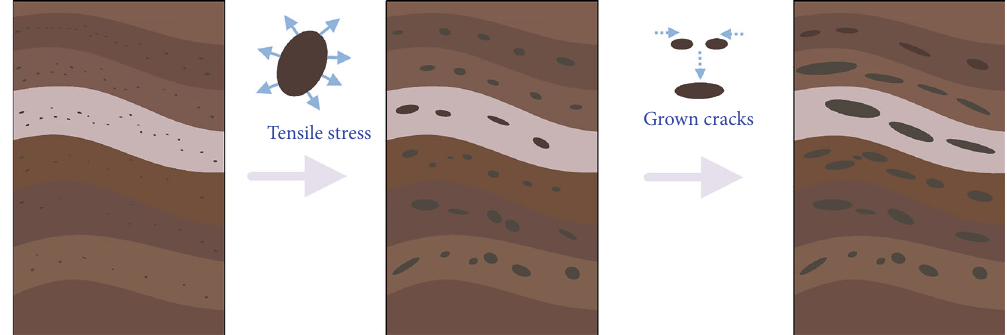
Figure 1: Schematic diagram of periodic freeze-thaw action process in oil shale samples.